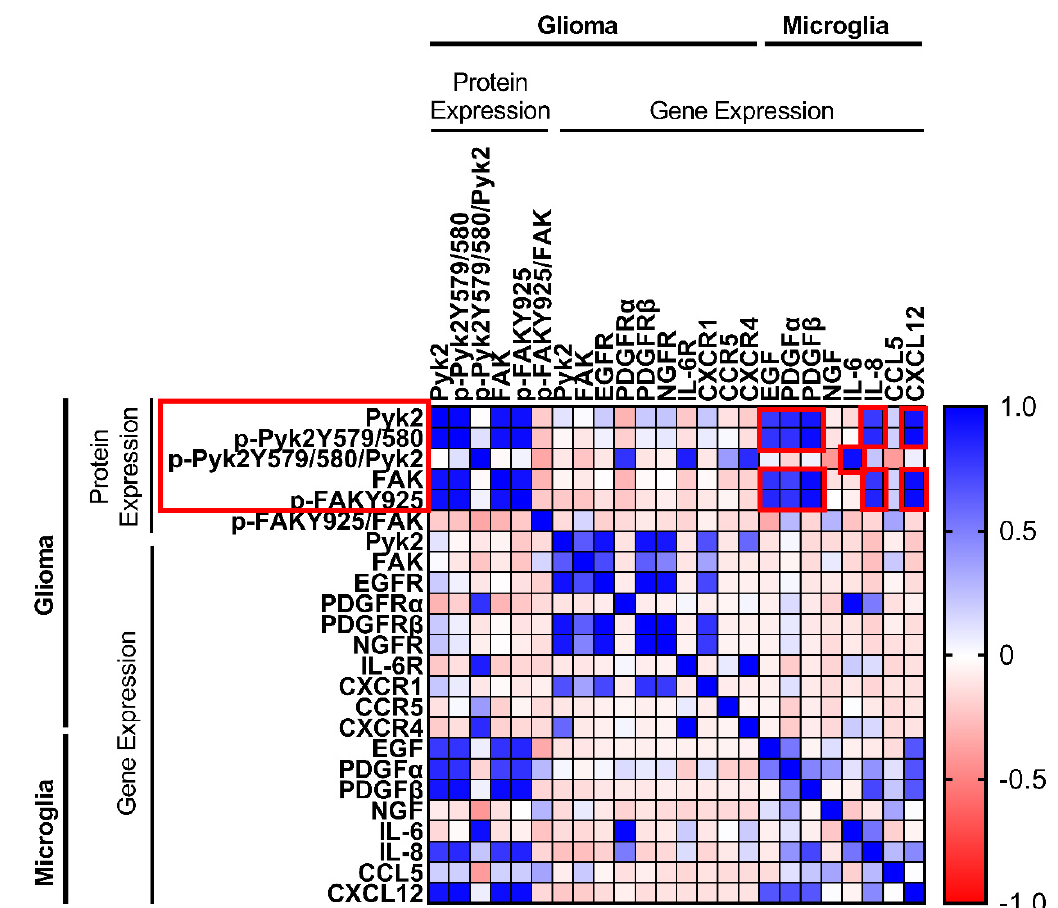
Figure 1. Heat map of Pearson correlation matrix for microglia cytokine and chemokine gene expression and the corre- sponding cell-surface receptor gene expression, as well as Pyk2 and FAK gene and protein expression in human glioma cells. Cytokines/chemokines with a strong correlation (+0.6–+1.0) selected for further study are highlighted in red ( n = 20).